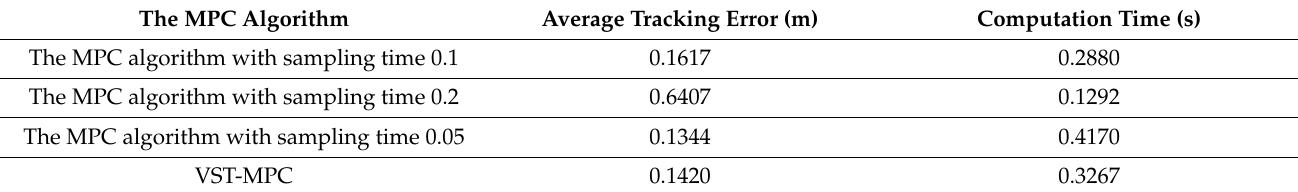
Figure 5. ( a ) The trajectory of section A, ( b ) the trajectory of section B.